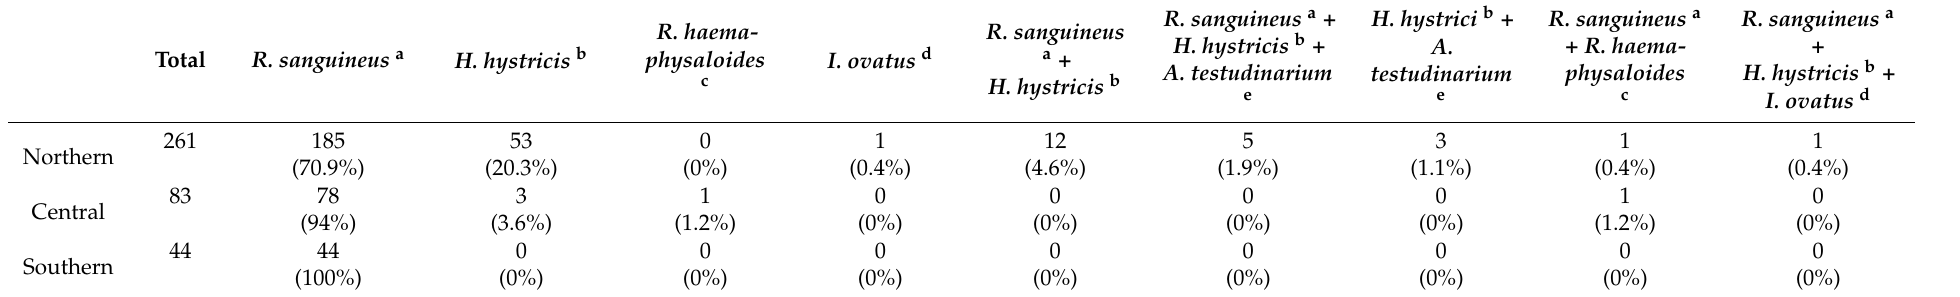
Table 1. The distribution of tick species collected from 388 dogs in northern, middle, and southern regions of Taiwan.